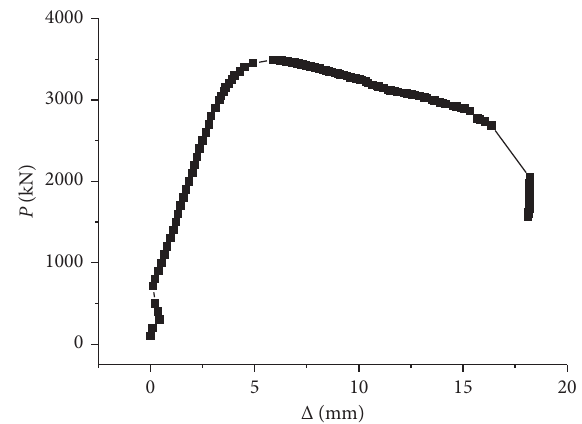
Figure 8: The load-displacement